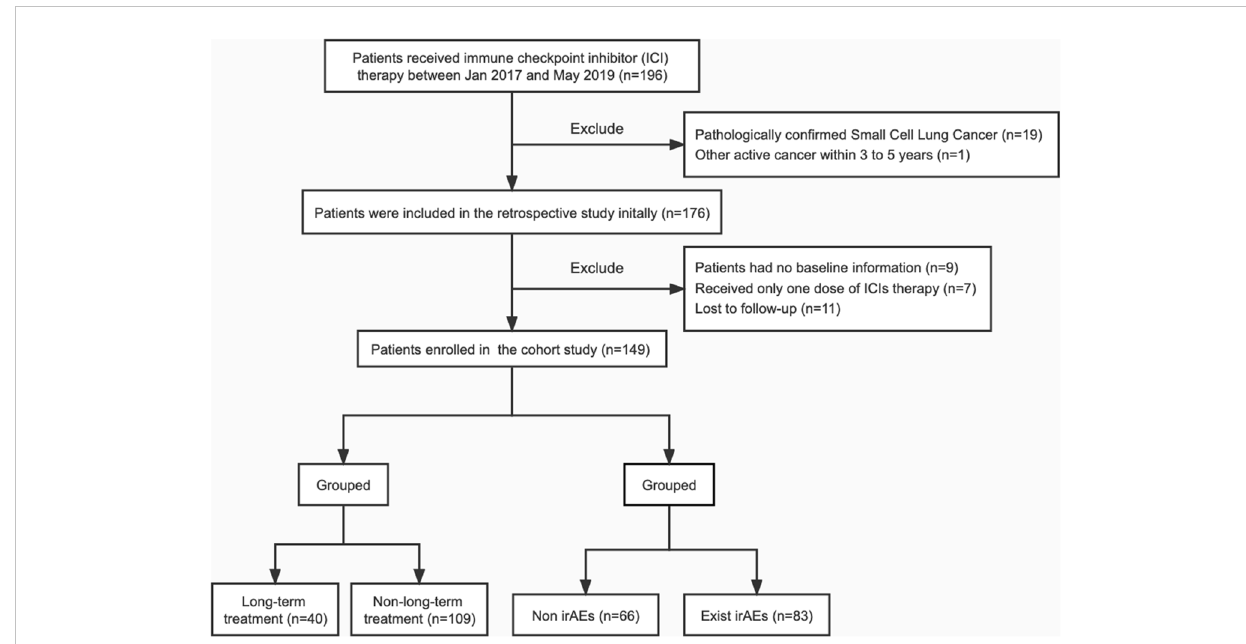
FIGURE 1 Flow chart of the study design. ICI, immune checkpoint inhibitor; irAEs, immune-related adverse